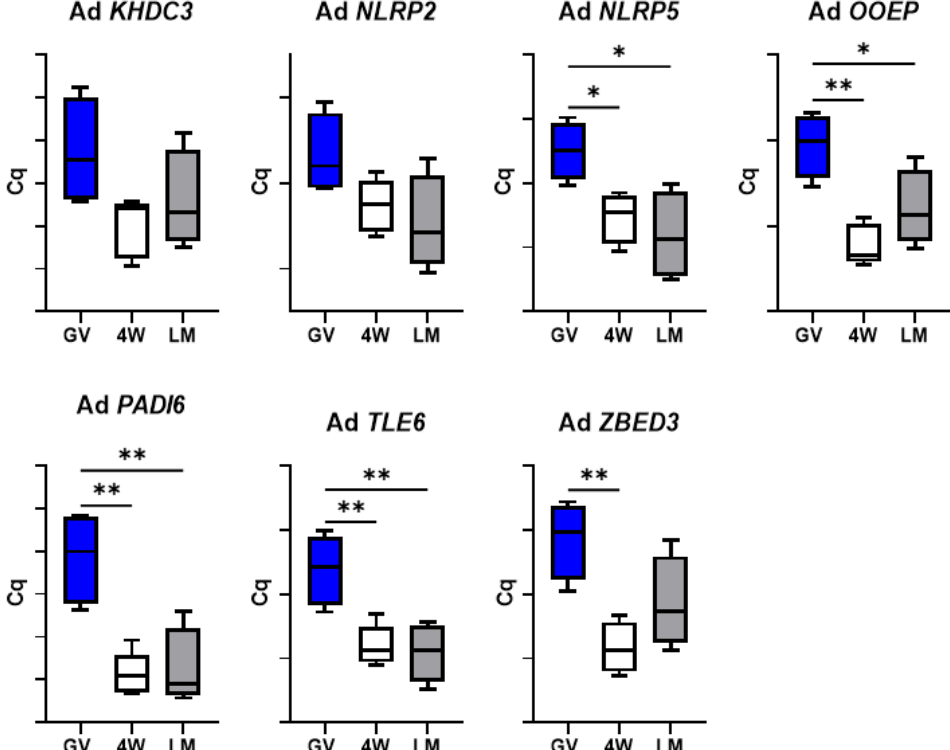
Figure 3. Expression of the subcortical maternal complex (SCMC) components in pools of adult GV and MII oocytes matured in 4-well plates (4W) or in liquid marbles (LM). Target gene expression was normalized against the l uciferase exogenous control. Relative abundance is expressed as ΔCq ( Y -axis). Each box represents the mean expression of 5 replicate pools of 10 oocytes each (mean ± SE). Significant differences were assessed by ANOVA general linear model test; * p < 0.05 ** p < 0.01.